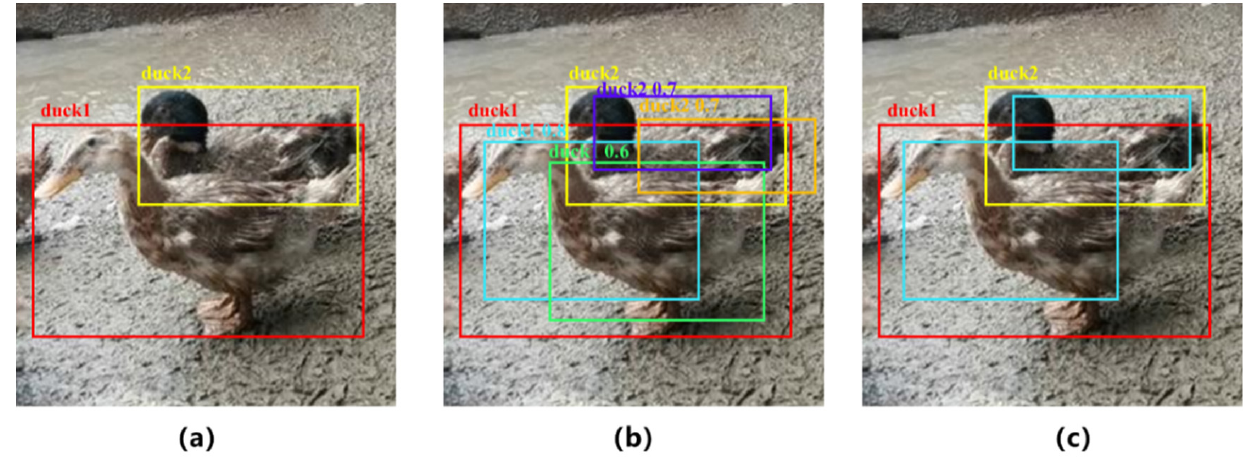
Figure 1. ( a ) Two ground truth boxes of hemp ducks; ( b ) output prediction boxes of the simulated network for the two hemp ducks; ( c ) effect of removing the redundant prediction boxes after non- maximum suppression.